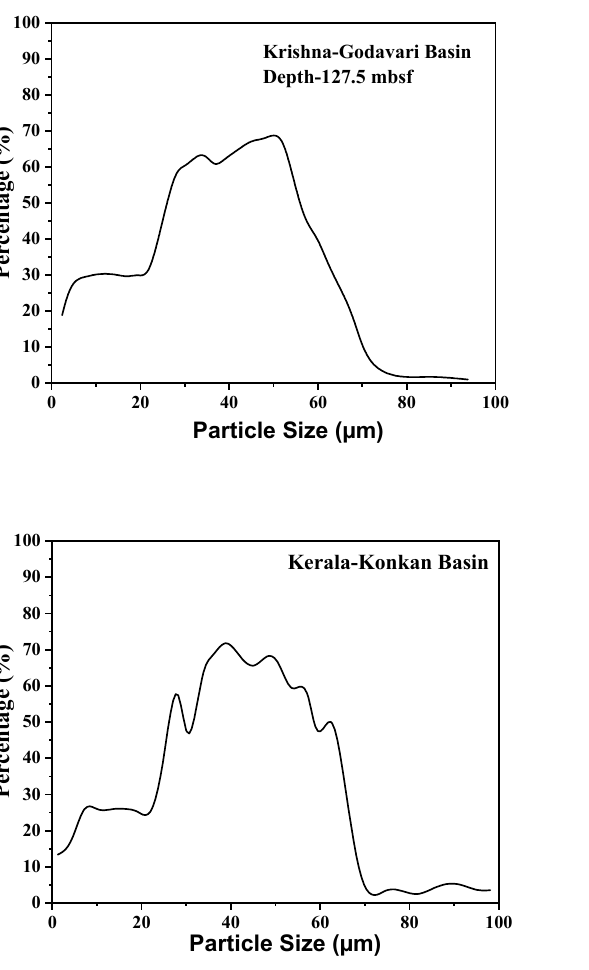
Figure 3. Particle size analysis of hydrate-bearing sediments. Table 3. Minimum and maximum value of particle size diameter.